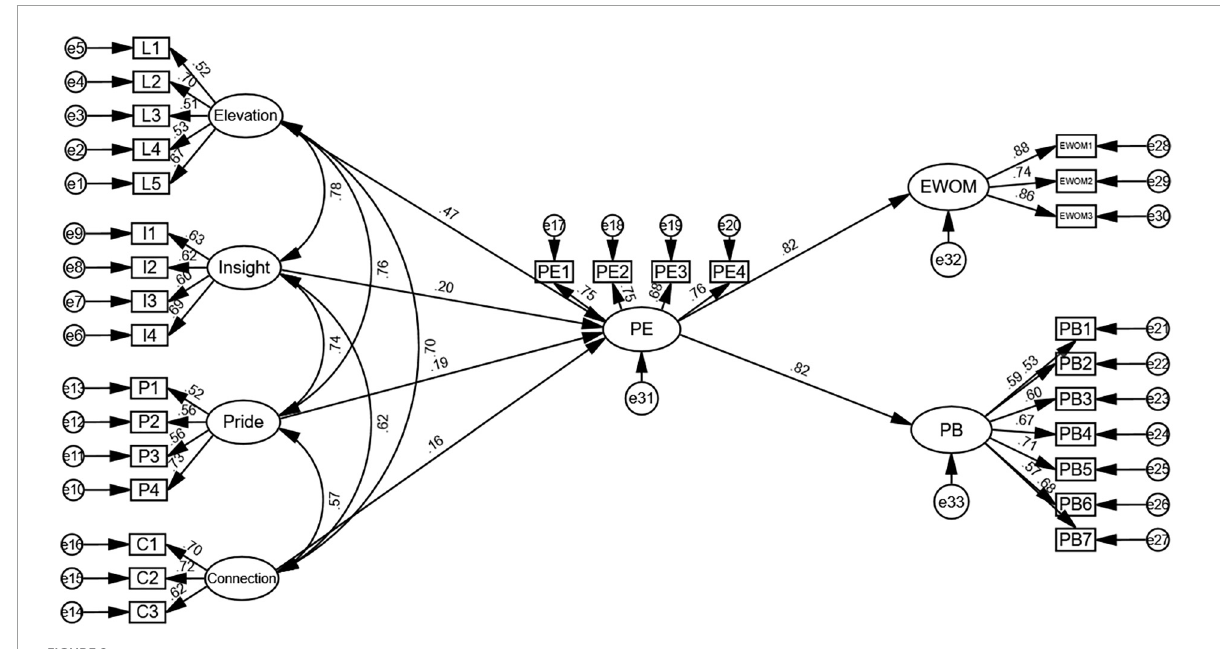
FIGURE2 Structural